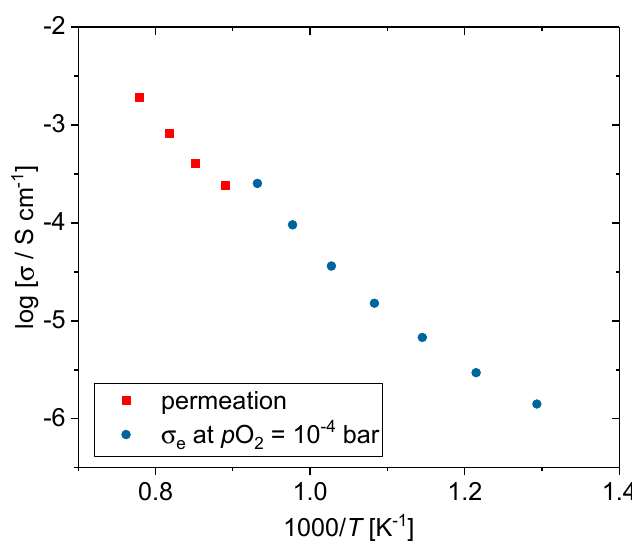
Figure 9. Electronic conductivity calculated via Equations (6) and (7) as function of electrical conductivity determined by impedance spectroscopy.